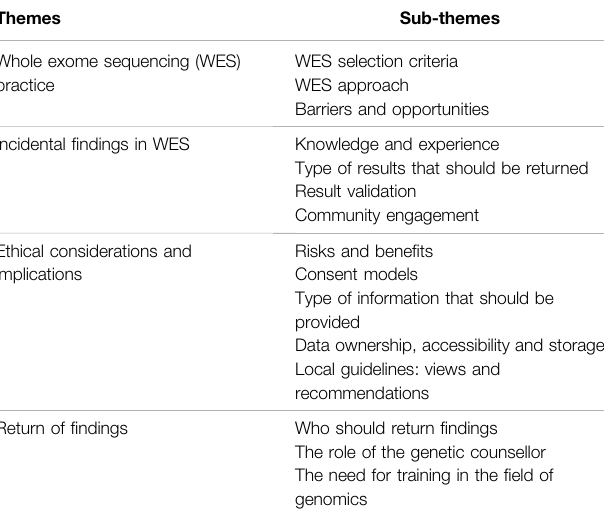
TABLE 1 | Themes and sub-themes generated during the data analysis phase of the